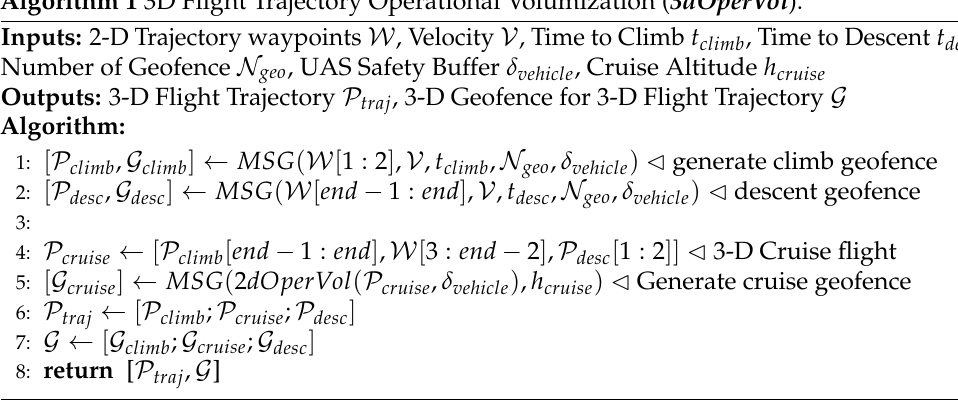
Algorithm 1 3D Flight Trajectory Operational Volumization ( 3dOperVol